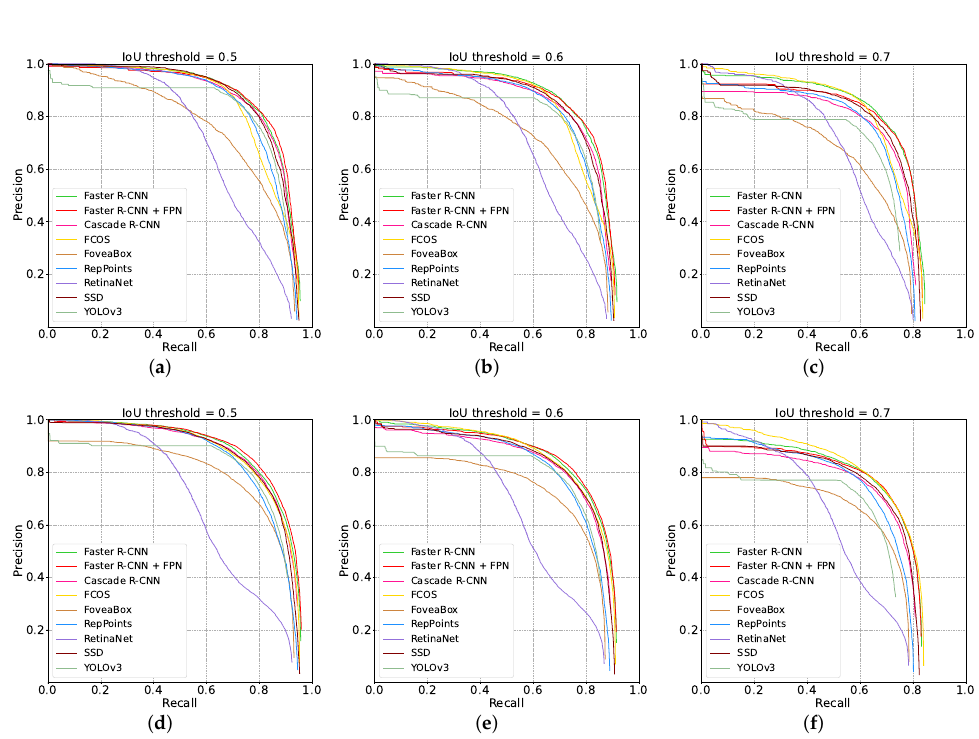
Figure 7. Precision-recall (P-R) curves of nine CNN models with different IoU thresholds on the validation ( a – c ) and test ( d – f )